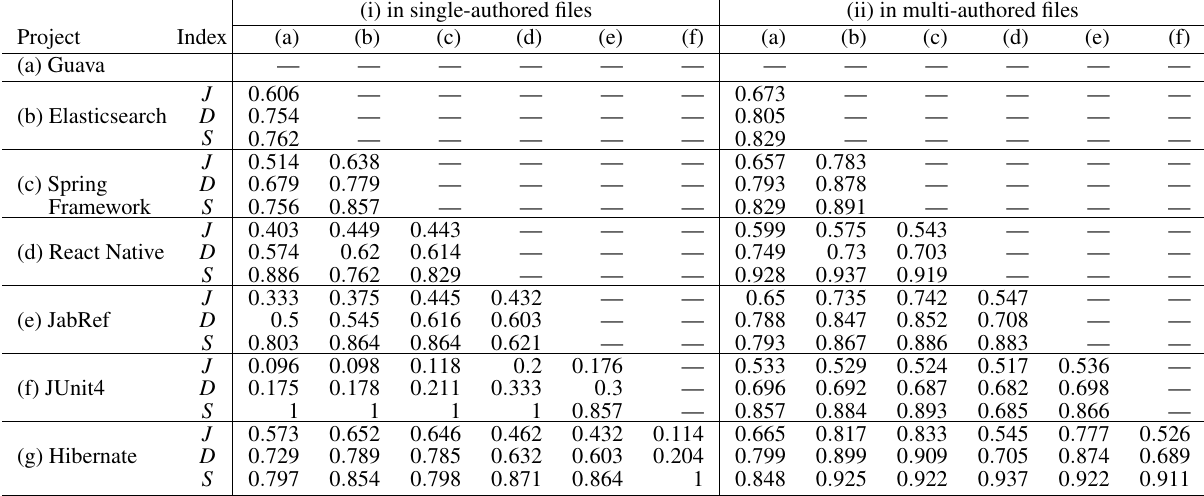
Table 8. Similarities of appearing violatins among projects.